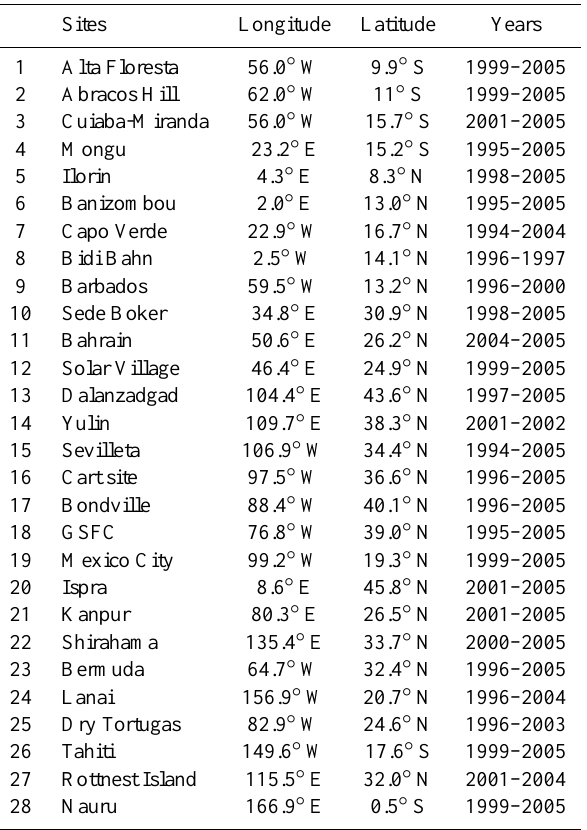
Table 7. Locations of AERONET sites and corresponding measure- ment time